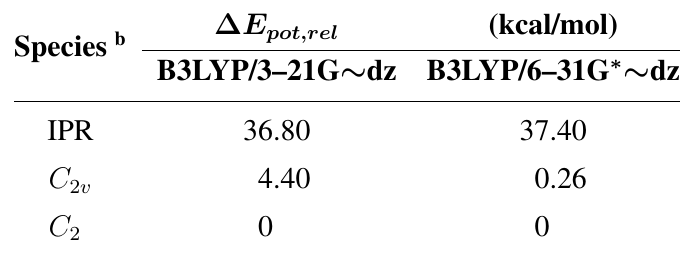
Table 1. La@C relative potential energies ∆ E 72 optimized